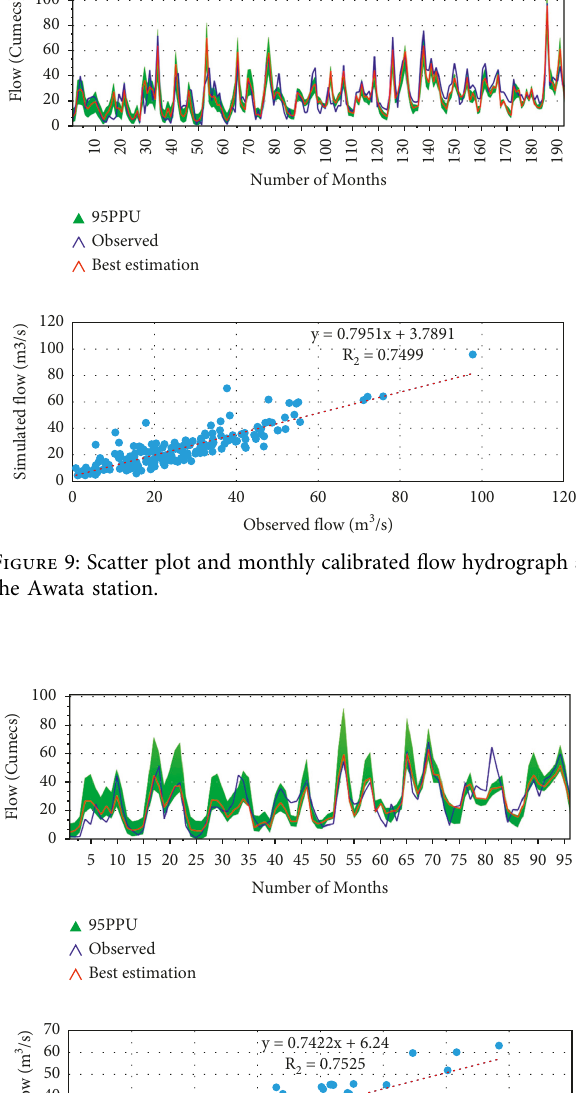
y = 0.7422x + 6.24 R 2 = 0.7525